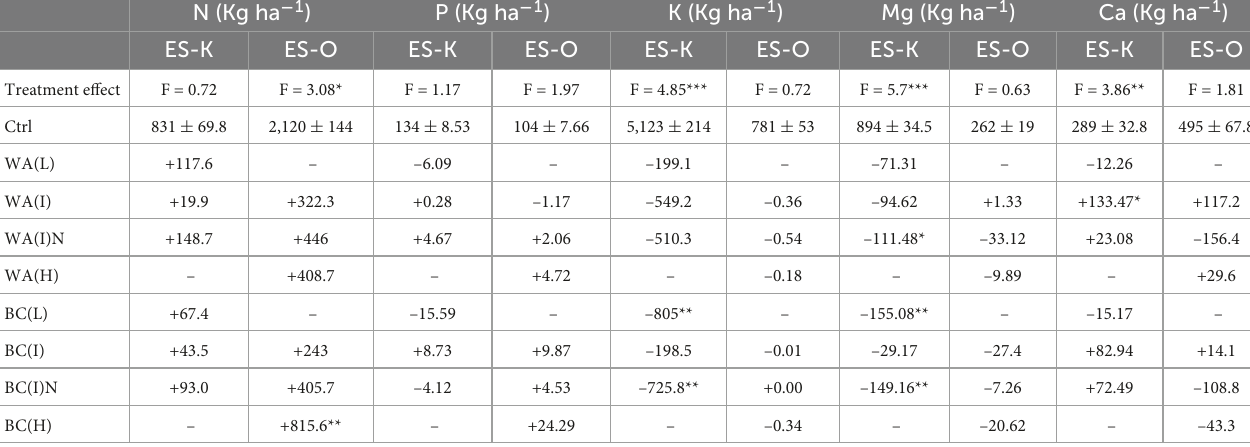
TABLE 3 Effects of the treatments (Third row) in soil nutrients, reported by F-values of the ANOVAs (df = 6).